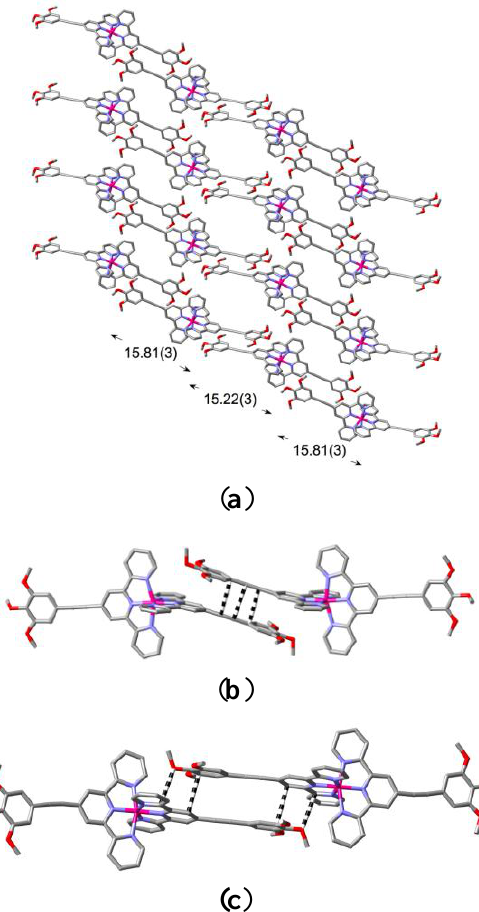
interactions. Alkynyl-C…C-alkynyl is 3.296(7), alkynyl-C…C-aromatic is 3.262(7) Å; ( c ) Weaker π-type interactions within the more remote centrosymmetric pair of a